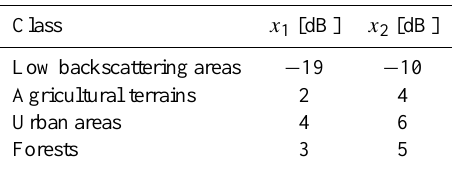
Table 1. Default fuzzy thresholds derived from the electromagnetic models for X band, incidence angle equal to 35 ◦ , horizontal polar- ization. Class x 1 [dB] x 2 [dB] Low backscattering areas − 19 − 10 Agricultural terrains 2 4 Urban areas 4 6 Forests 3